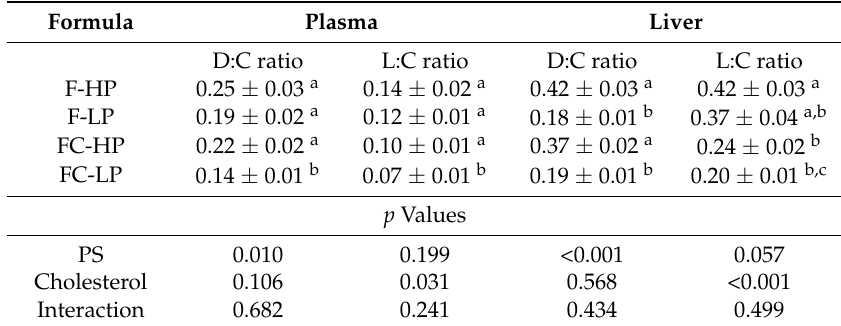
Table 4. Cholesterol precursor concentrations in plasma and liver samples of piglets fed formulas with varying PS and cholesterol content.